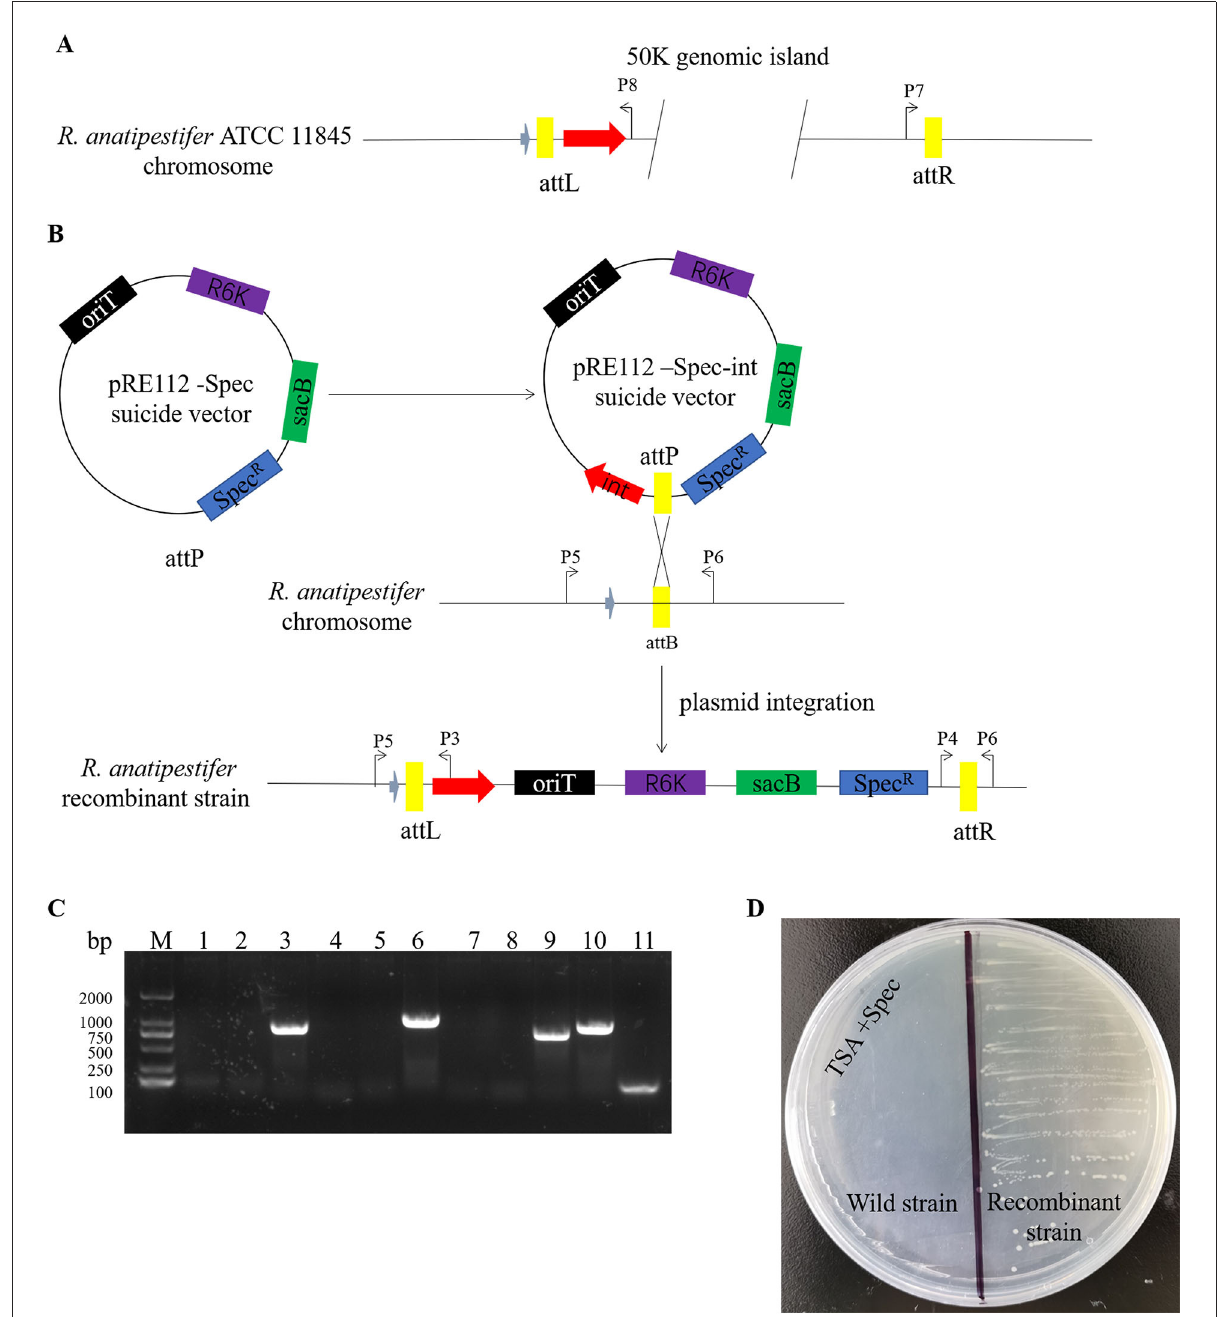
FIGURE6 Identification of an integrase from phage RAP44-mediated integration in R. anatipestifer . (A) The integase with promoter and attP site was cloned with P7/P8 primer pairs. (B) The DNA fragments were cloned into suicide vector pRE112-Spec, the recombinant vector named pRE112-Spec-int. The construction diagram of integration vector is shown. (C) The recombinant strain was selected using Spec antibiotic plate and called R. anatipestifer RAint. Integration and excision were detected by PCR in the recombinant strain. M: DL2000 DNA marker; lane 1: Spec gene fragment was amplified with Spec F/R primer pair from R. anatipestifer clinical isolated strain no. 1; lane 2: DNA fragment was amplified with P3/P4 primer pair from R. anatipestifer clinical isolated strain no. 1; lane 3: DNA fragment was amplified with P5/P6 primer pair from R. anatipestifer clinical isolated strain no. 1; lane 4: DNA fragment was amplified with P4/P6 primer pair from R. anatipestifer clinical isolated strain no. 1; lane 5: DNA fragment was amplified with P3/P5 primer pair from R. anatipestifer clinical isolated strain no. 1; lanes 6–10: DNA fragment was amplified with same primer from recombinant strain; lane 11: negative control. Plasmid was integrated into R. anatipestifer , and the insert site was consistent with the R. anatipestifer ATCC 11845 and RA-YM. The recombinant strain only had the function of integration and loss of the function of excision. (D) Integrase-mediated integration has genetic stability. The well expression of Spec resistance cassette in recombinant bacteria after 20 passages in TSA pallet without